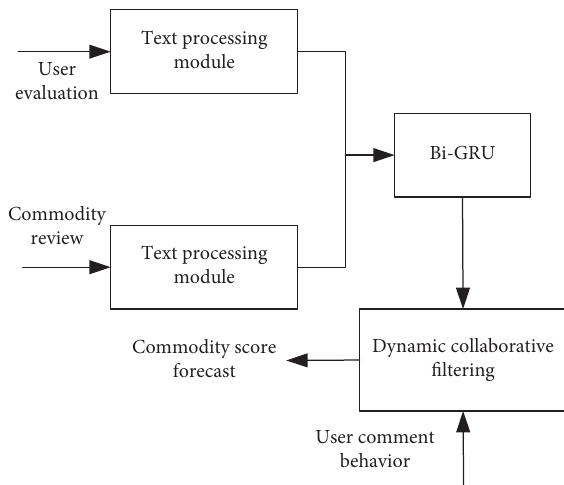
Figure 1: Recommended model